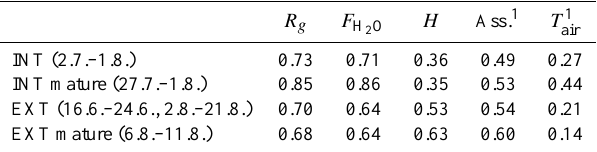
Table 1. Correlation coefficients ( r 2 ) of growth related methanol flux ( F MeOH ) with various environmental parameters: global radia- ) , sensible heat flux ( H ), carbon tion ( R g ) , water vapour flux ( F H 2 O assimilation (Ass.), and air temperature ( T air ) , calculated for the en- tire growing period and the mature period,